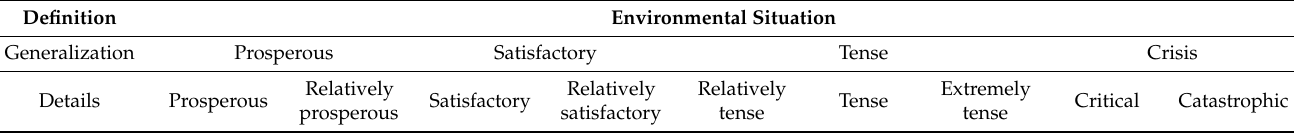
Table 4. Definitions of ecological situation